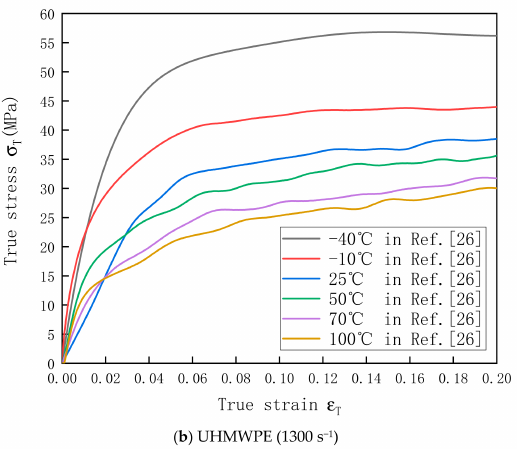
Figure 9. Stress–strain curves of ( a ) HDPE and ( b ) UHMWPE at different temperatures. The relationships between the yield stress and temperature for HDPE and UHMWPE are illustrated in Figure 10a,b, respectively. The results indicate that the yield stress was nonlinearly correlated with temperature for both materials, and the nonlinear relationship was more prominent in UHMWPE. According to the comparison between Figure 10a,b, HDPE showed better high-temperature resistance than UHMWPE under the same con- ditions. From Figure 10, it can also be inferred that for both materials, the relationship between the yield stress and temperature under quasistatic conditions was different from that under dynamic conditions.